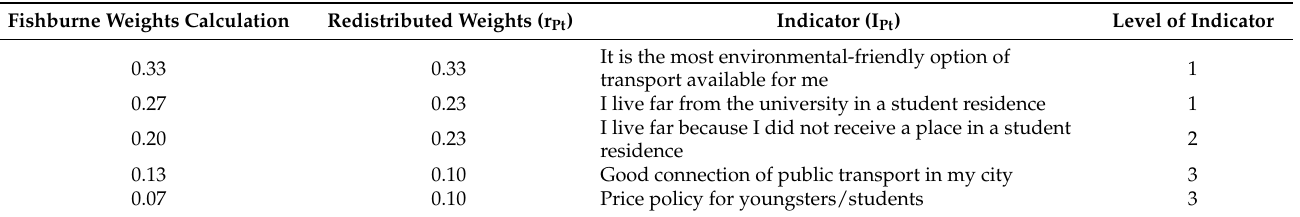
Table 24. Reasoning indicators for public transport.